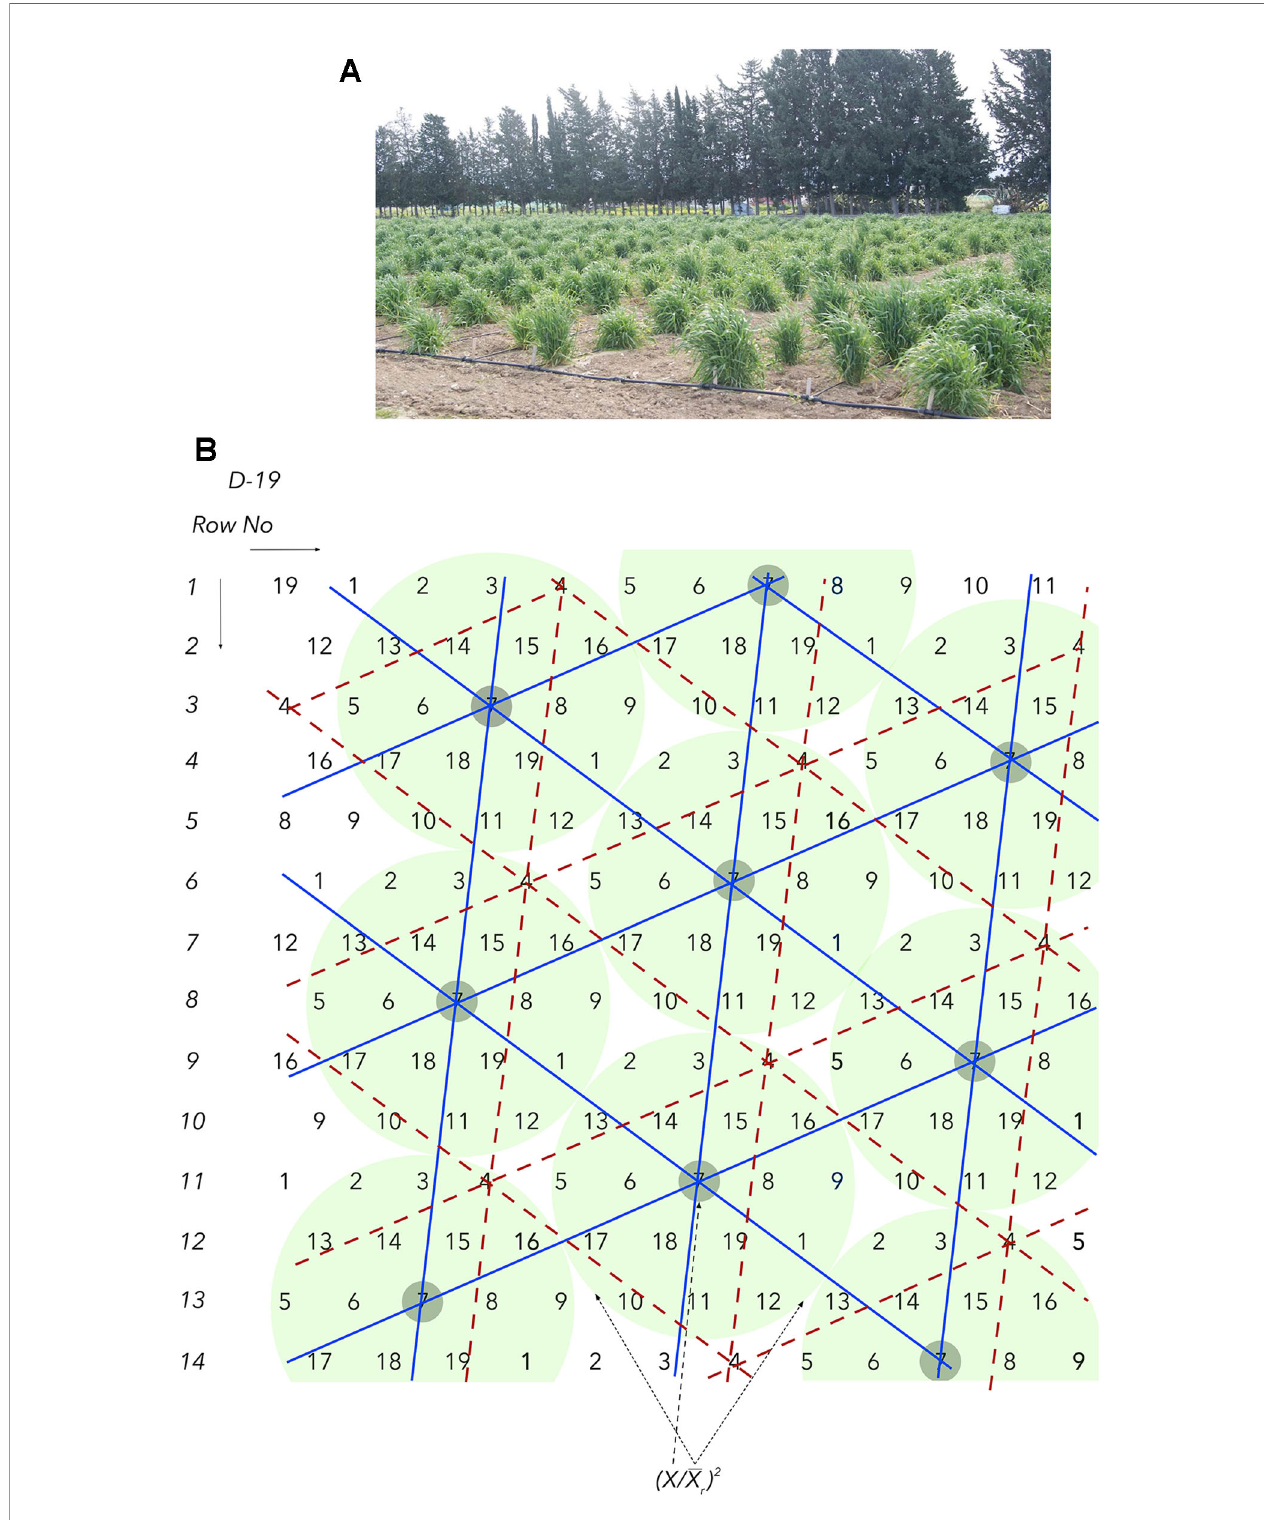
FIGURE 1 | (A) All barley biomass and the multiple, fertile tillers (>70) in each fi eld spot correspond to a single seed. The number of replications are commonly 40 – 120 and plant spacing is 100 cm. (B) The honeycomb selection design D19 is used to demonstrate the principles of moving complete replicates and grids and the components of the prognostic